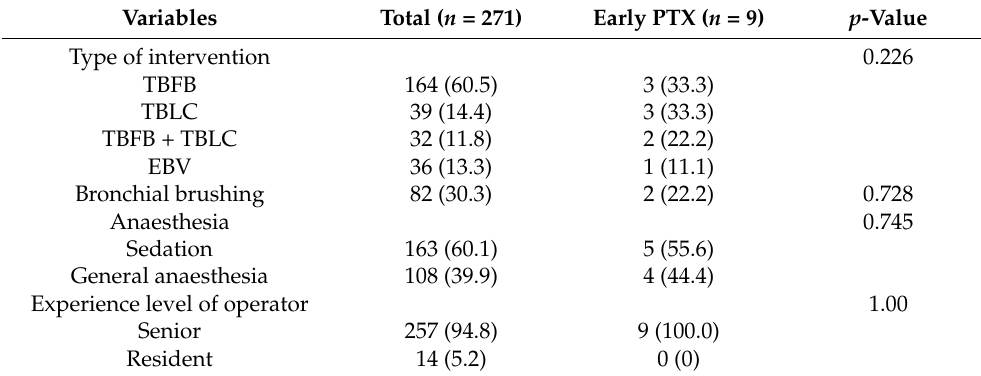
Table 3. Procedural data.